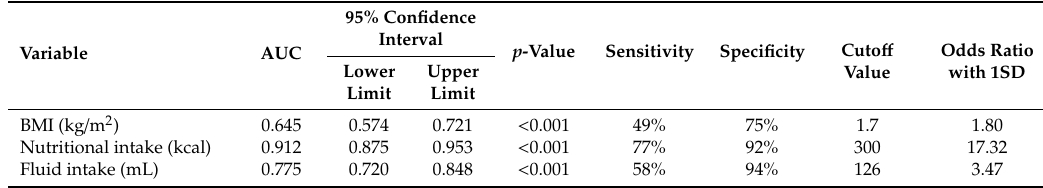
Figure 2. ROC curves for the amount of change during the year prior to death and the period from 24 months to 12 months prior to death. Table 4. AUC, cutoff value, and odds ratio of each parameter.